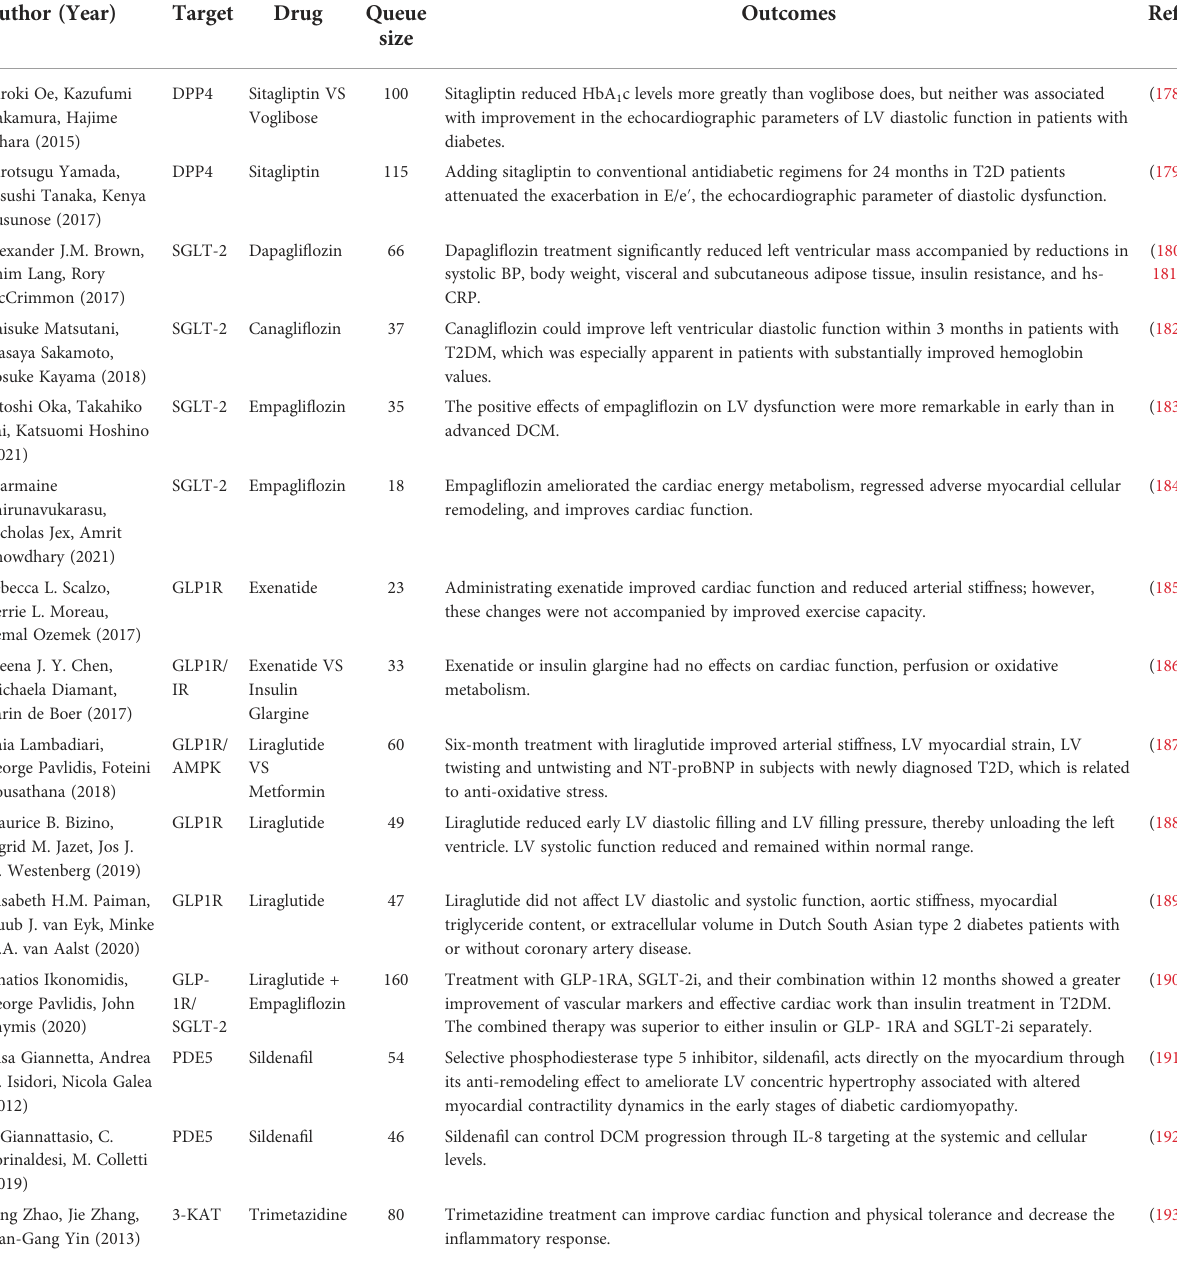
TABLE 4 Main RCTs on diabetic